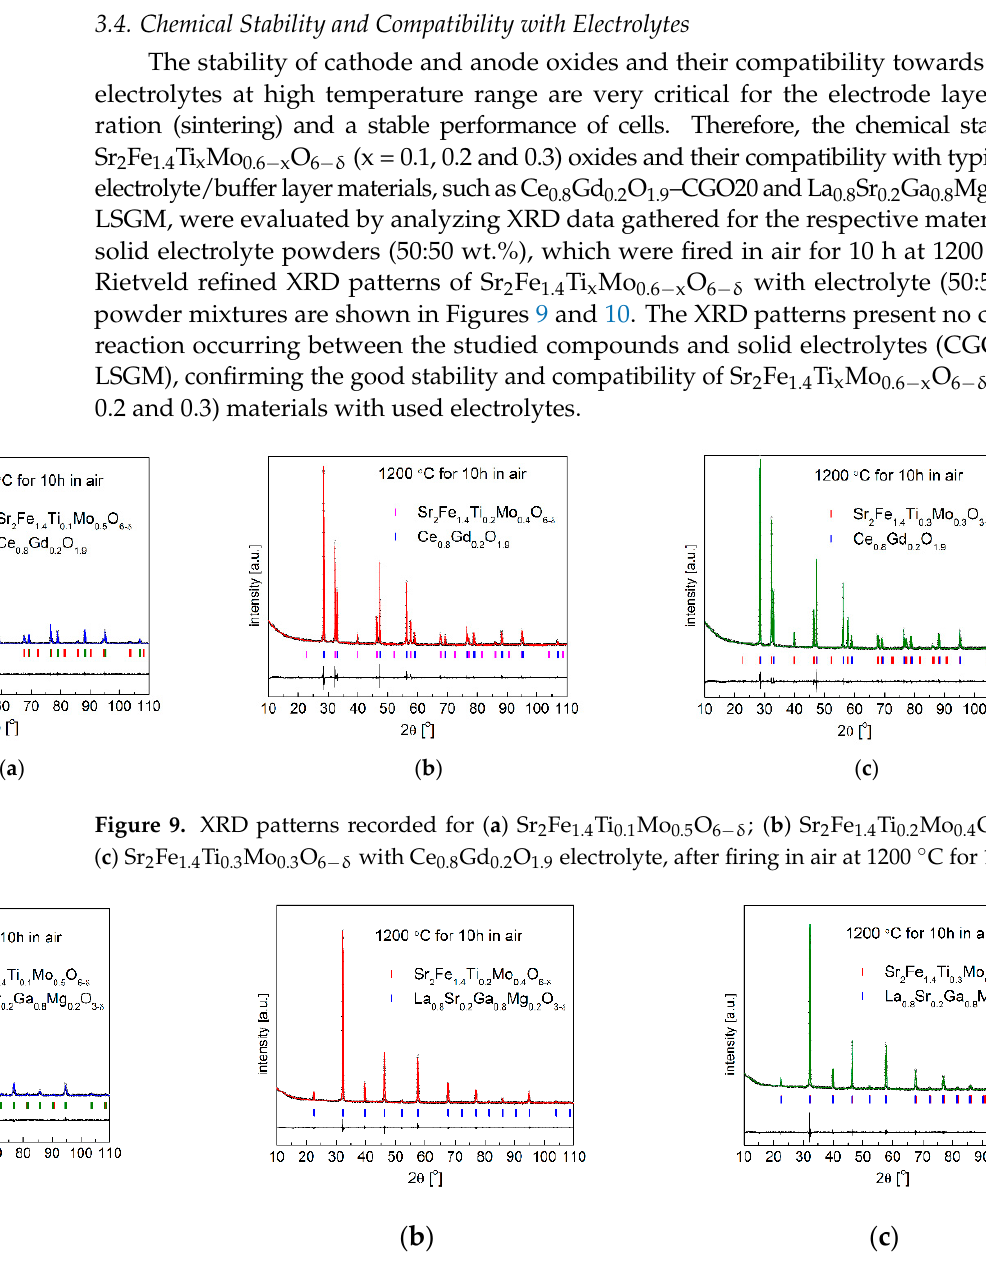
Figure 10. XRD patterns recorded for ( a ) Sr 2 Fe 1 . 4 Ti 0 . 1 Mo 0 . 5 O 6 −δ ; ( b ) Sr 2 Fe 1 . 4 Ti 0 . 2 Mo 0 . 4 O 6 −δ and ( c ) Sr 2 Fe 1 . 4 Ti 0 . 3 Mo 0 . 3 O 6 −δ with La 0 . 8 Sr 0 . 2 Ga 0 . 8 Mg 0 . 2 O 3 −δ electrolyte, after sintering at 1200 °C for 10 h in air.